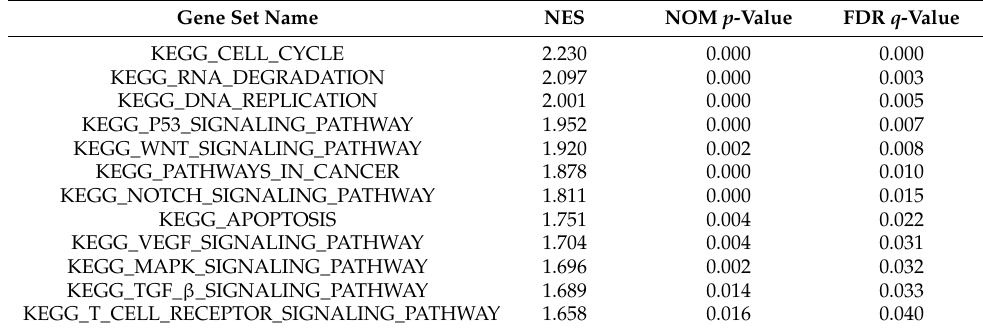
Table 5. Gene sets enriched in the high SGO2 expression phenotypes.